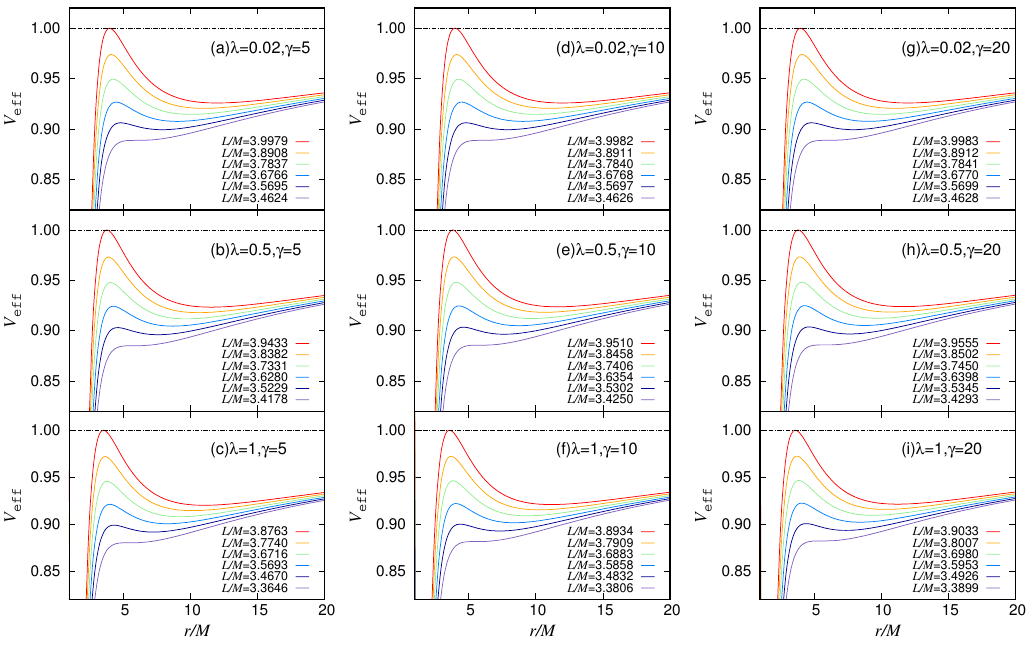
Figure 4. The effective potential V eff as a function of r / M with different values of L / M , λ , and γ . The angular momentum varies from L MBO / M to L ISCO / M from top to bottom.